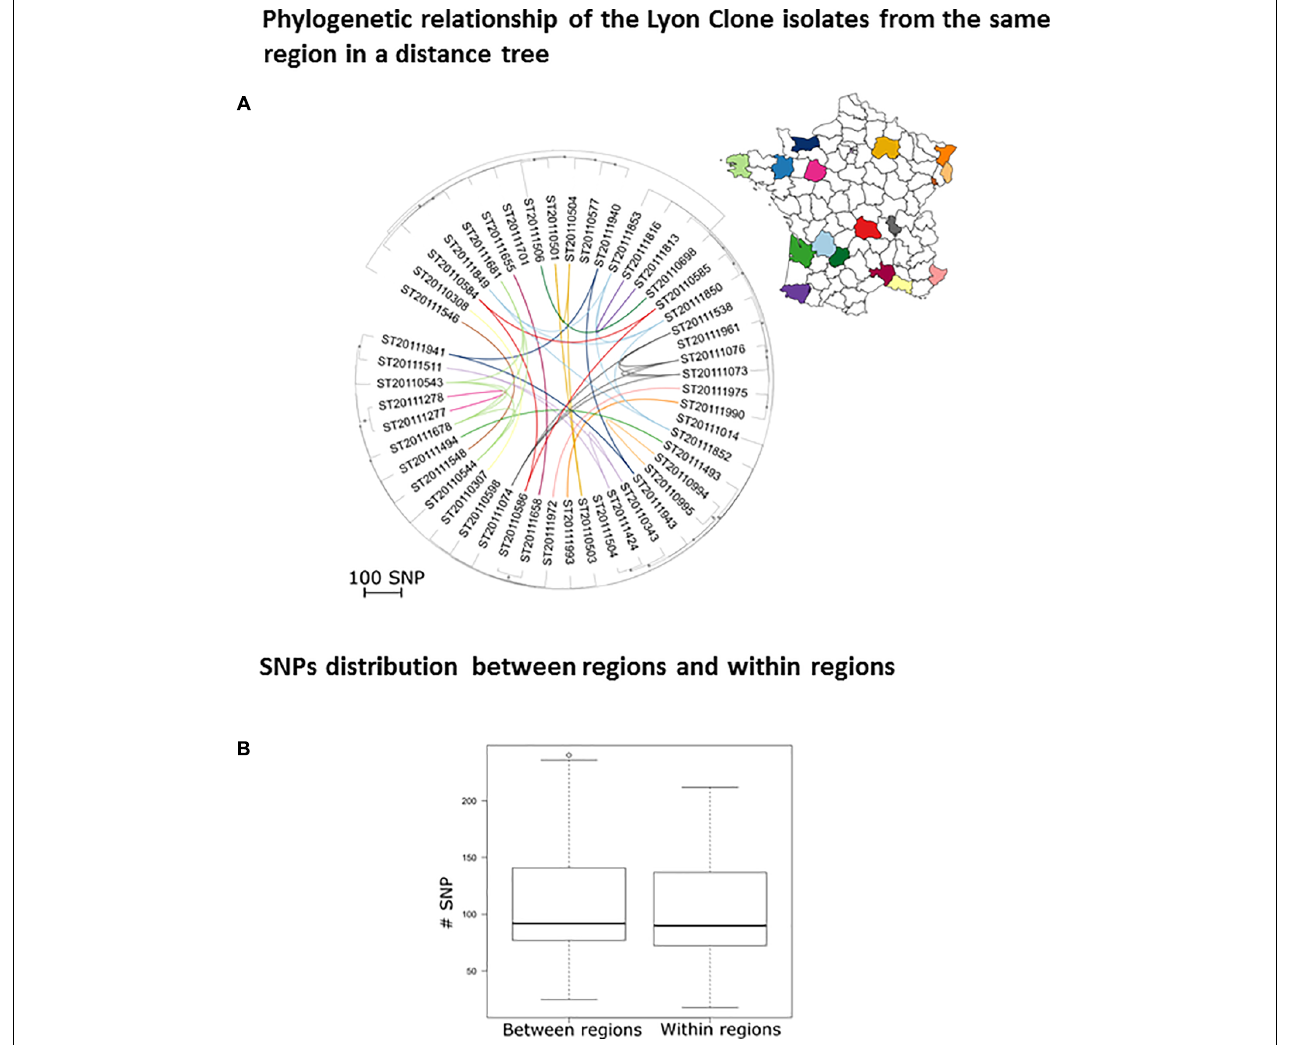
FIGURE 1 | Phylogeographic diversity of the Lyon clone. (A) Rooted neighbor-joining tree based on the SNP distances between Lyon clone isolates ( n = 50). The scale represents the number of SNPs in 1,524 core genes. The dots indicate nodes supported by a bootstrap score over 80, based on 100 repetitions. The lines signify clones isolated in the same region and the color code indicates the geographical origin. (B) Box plot of the number of SNPs between clone Lyon isolates from the same regions (intra) and between isolates belonging to different regions